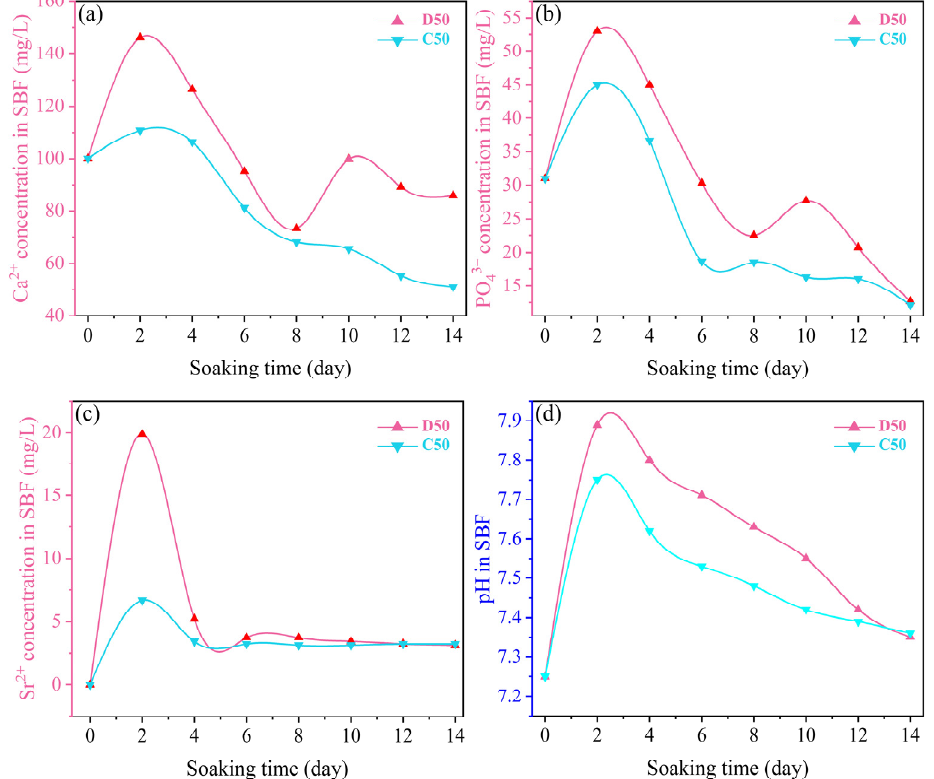
Figure 14. Variations of ( a ) Ca 2+ , ( b ) PO 43 − and ( c ) Sr 2+ concentrations, and ( d ) pH in the SBF after immersion of the deposition product (D50) and calcination product immersion of the deposition product (D50) and calcination product (C50).